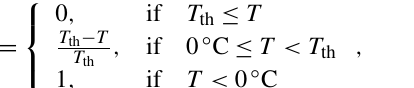
itation RegCMv4 model output accounting for the biases in the RegCMv4